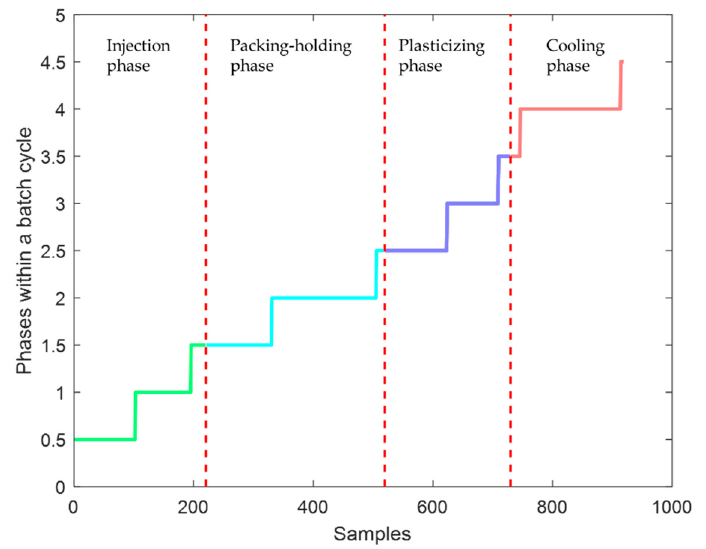
Figure 8. The final division results in the time direction.